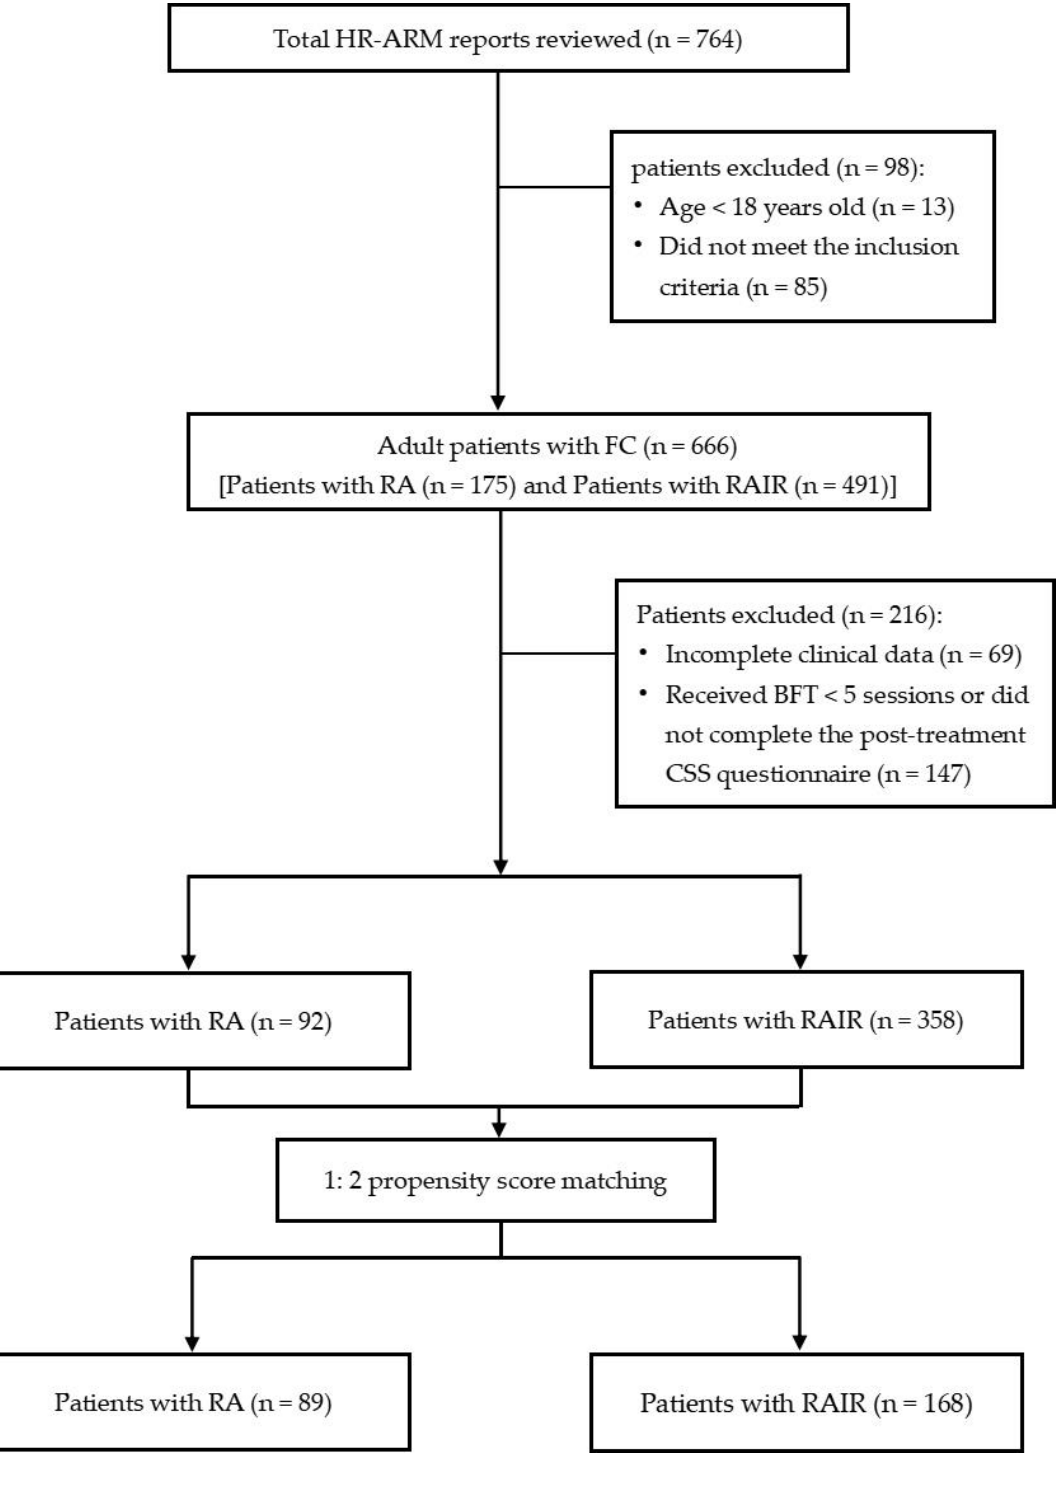
Figure 2. Flowchart for patient disposition. Abbreviations: BFT, biofeedback therapy; CSS, Constipation Scoring System; FC, functional constipation; HR-ARM, high-resolution anorectal manometry; RA, rectoanal areflexia; RAIR, rectoanal inhibitory reflex. Table 1. Baseline data after the PSM analysis.